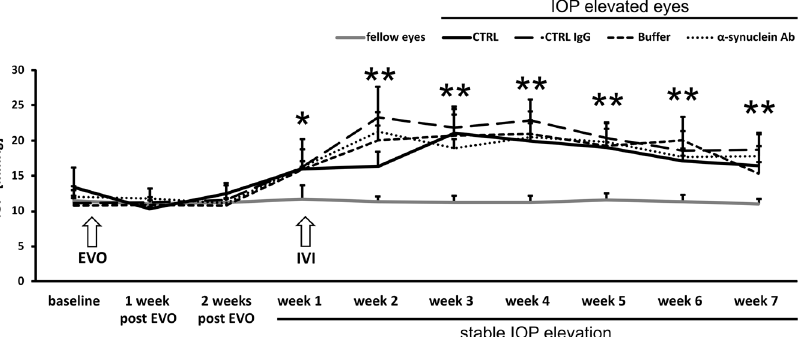
Figure 1. Follow-up of the intraocular pressure before and after episcleral vein occlusion and intravitreal injection. The time course shows the elevation of the IOP after episcleral vein occlusion (EVO). Three weeks after EVO, IOP was significantly elevated and remained high for the next weeks. At the timepoint of stable IOP elevation (week 1), intravitreal injections (IVI) were performed in CTRL IgG, Buffer and α -synuclein Ab group. IOP levels of IOP elevated eyes remained comparable between CTRL (black line), CTRL IgG (broken line), Buffer (hatched line) and α -synuclein Ab (dotted line). The IOP of fellow eyes (grey line) were not affected throughout the study. * Represents p < 0.05, ** represents p < 0.01 compared with fellow eyes at respective time